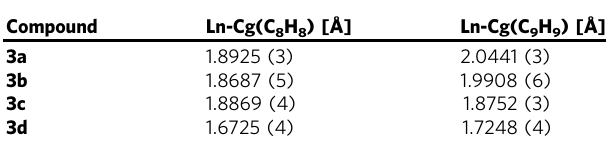
Table 1 Ln-Cg distances in the solid state of